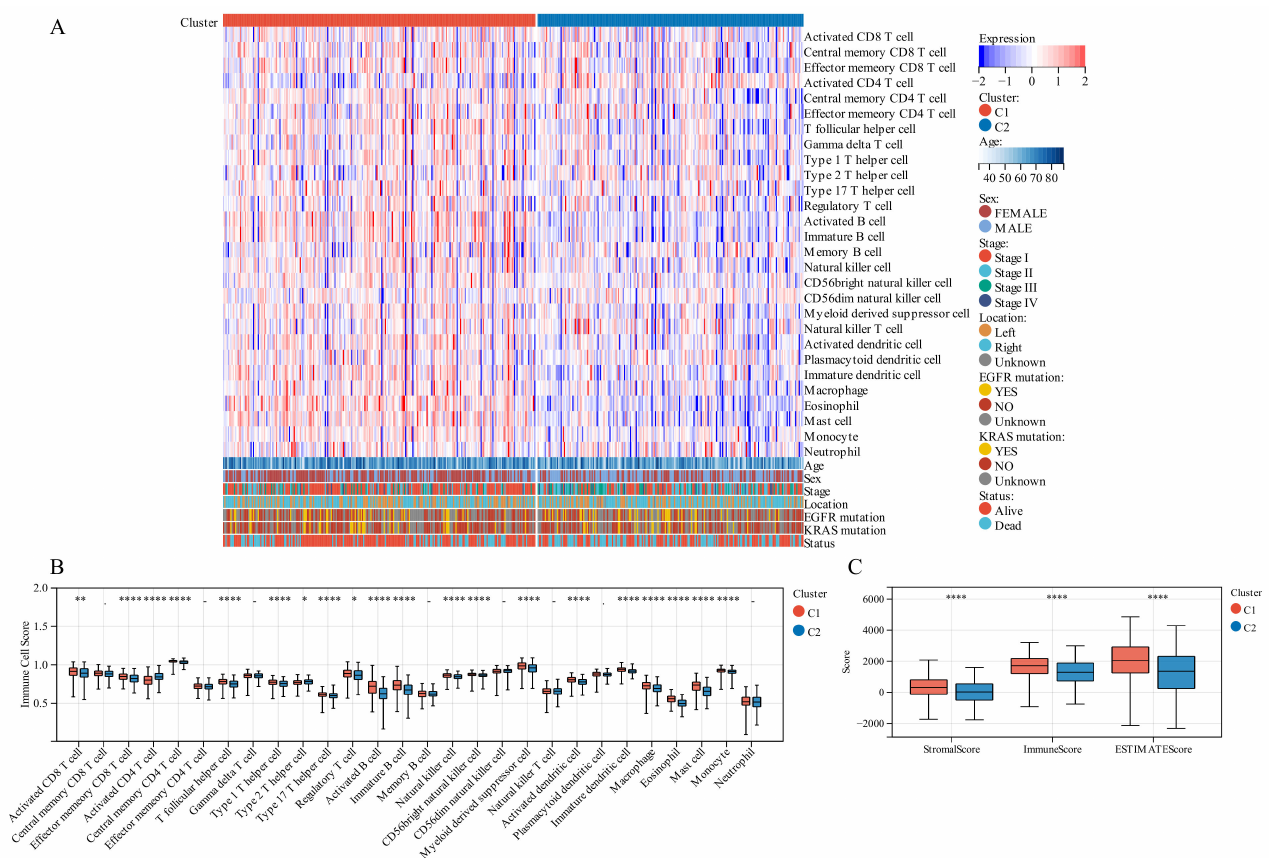
Figure 4. Tumor immune microenvironment (TIME) immunogenicity cell infiltration features and tumor purity in different TTK modes. ( A ) Heatmap displays the ssGSEA score of 28 immunogenicity cell features in different TTK modes, and survival status, KRAS mutation, EGFR mutation, tumor location, tumor stage, sex and age. ( B ) Each infiltrating cell type’s relative abundance differs between the different TTK modes. ( C ) Box plots present the ESTIMATE score for the different TTK modes in lung adenocarcinoma. Asterisks indicate significance, * p < 0.05; ** p < 0.01; **** p < 0.0001; -, no statistical